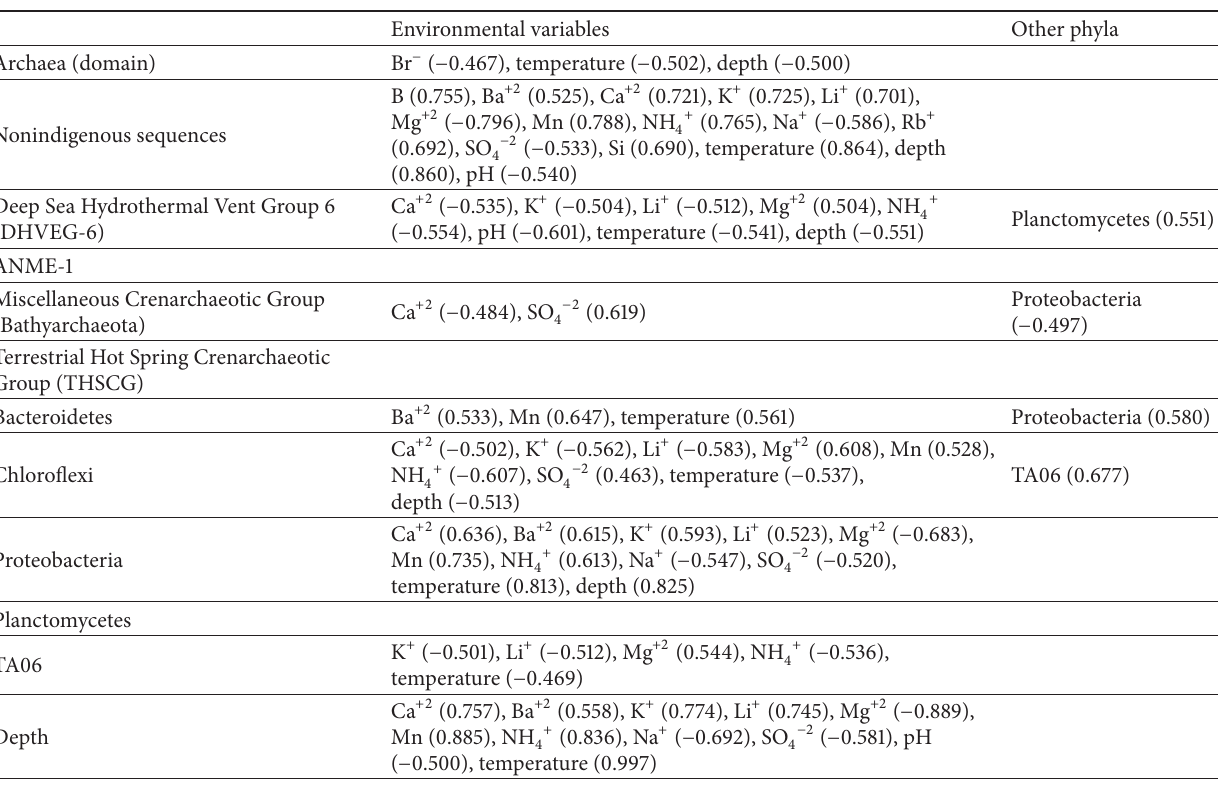
Table 1: Bivariate correlation values of environmental variables with significant correlation to dominant taxa (second column); taxa that have significant correlations with one another (third column); and environmental variables that have significant correlation with depth (bottom row). The chemical species abbreviation or taxon name is listed with the correlation value in parentheses. All correlation values listed here are significant at the 0.01 level